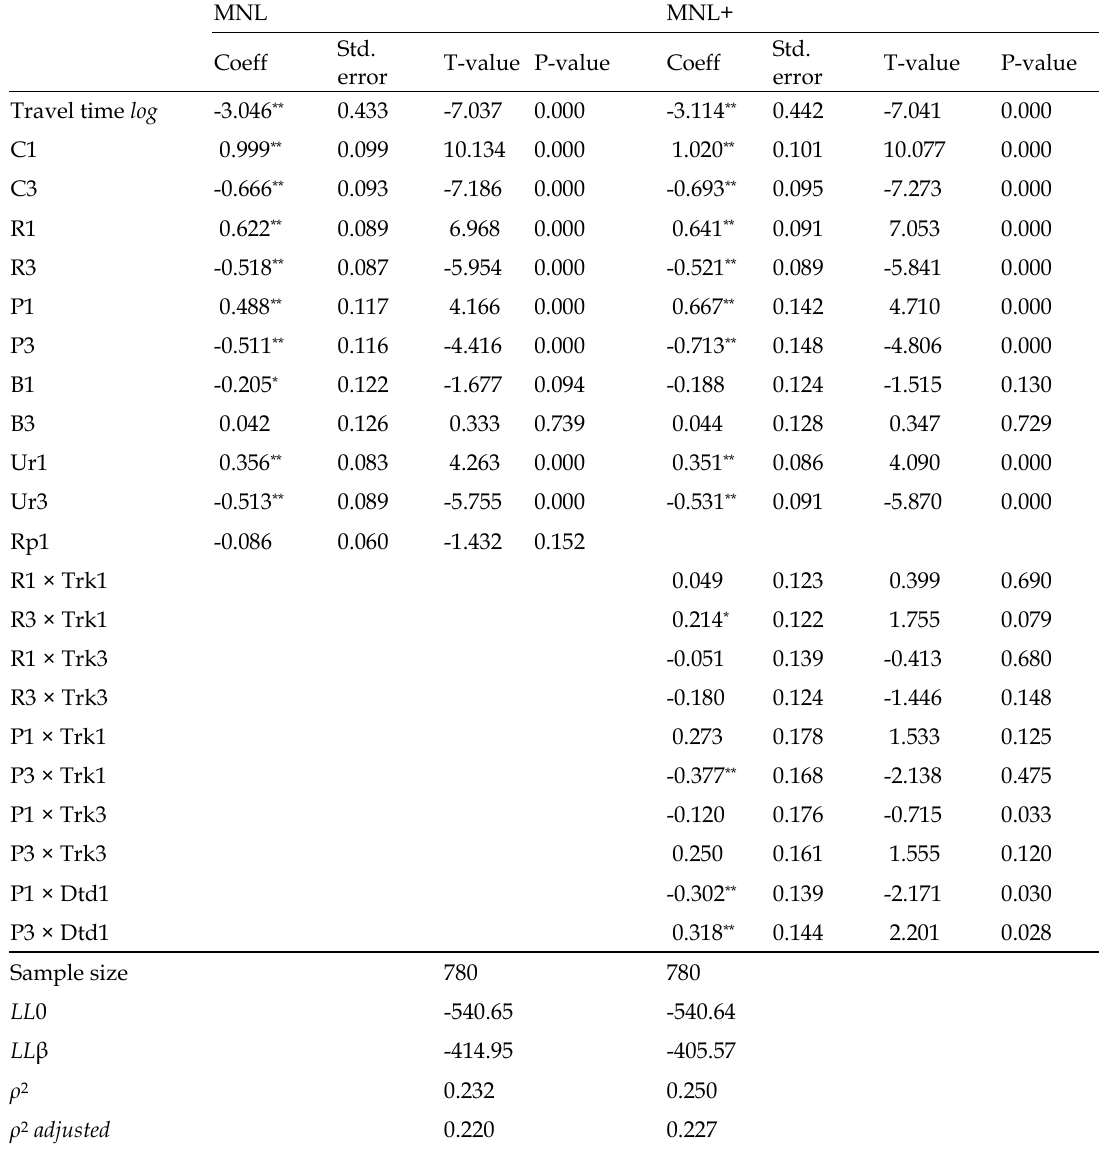
Table 3 Estimation results of MNL and MNL+